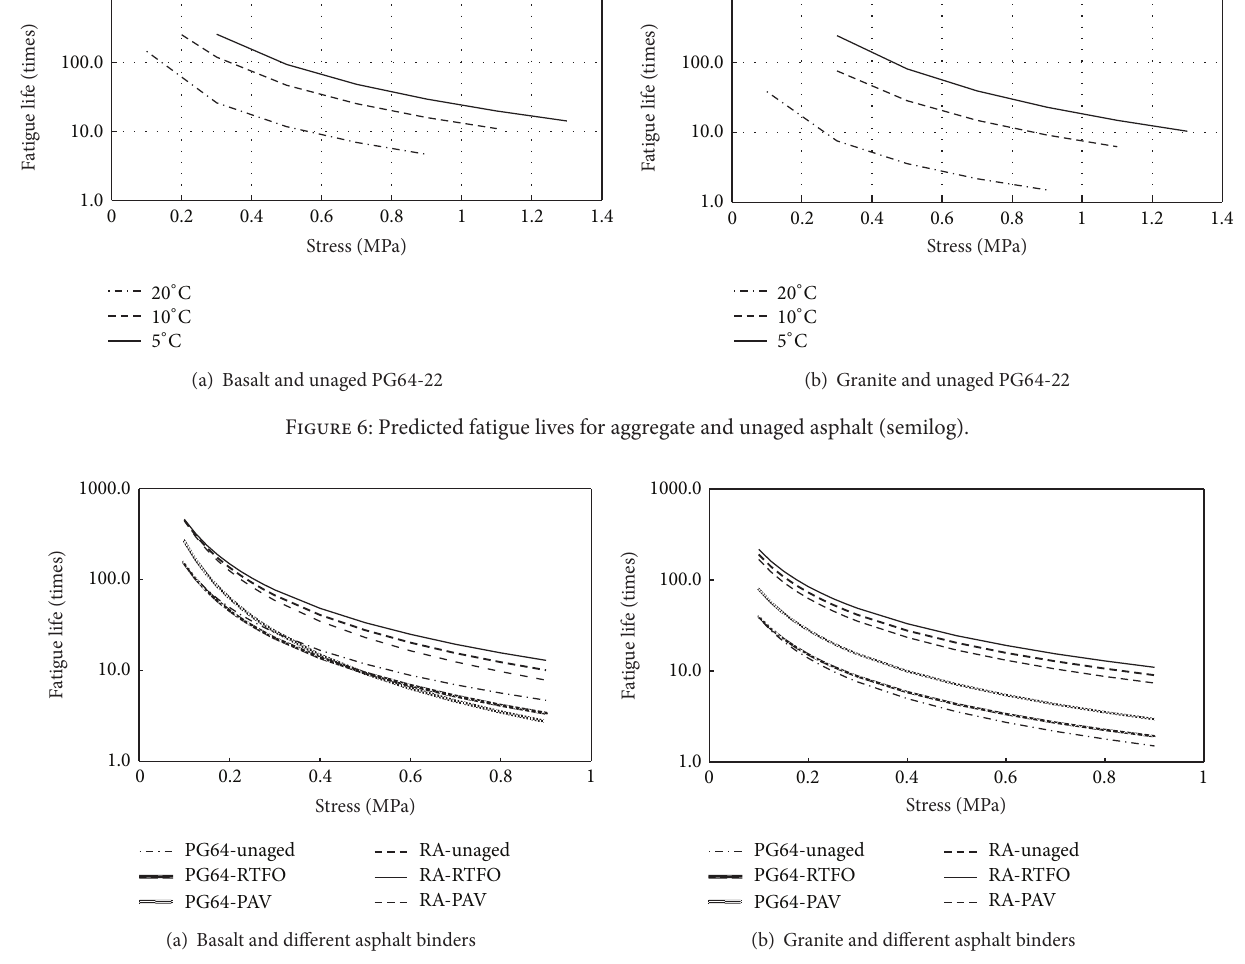
Figure 7: Predicted fatigue lives (semilog) for aggregate and different asphalt